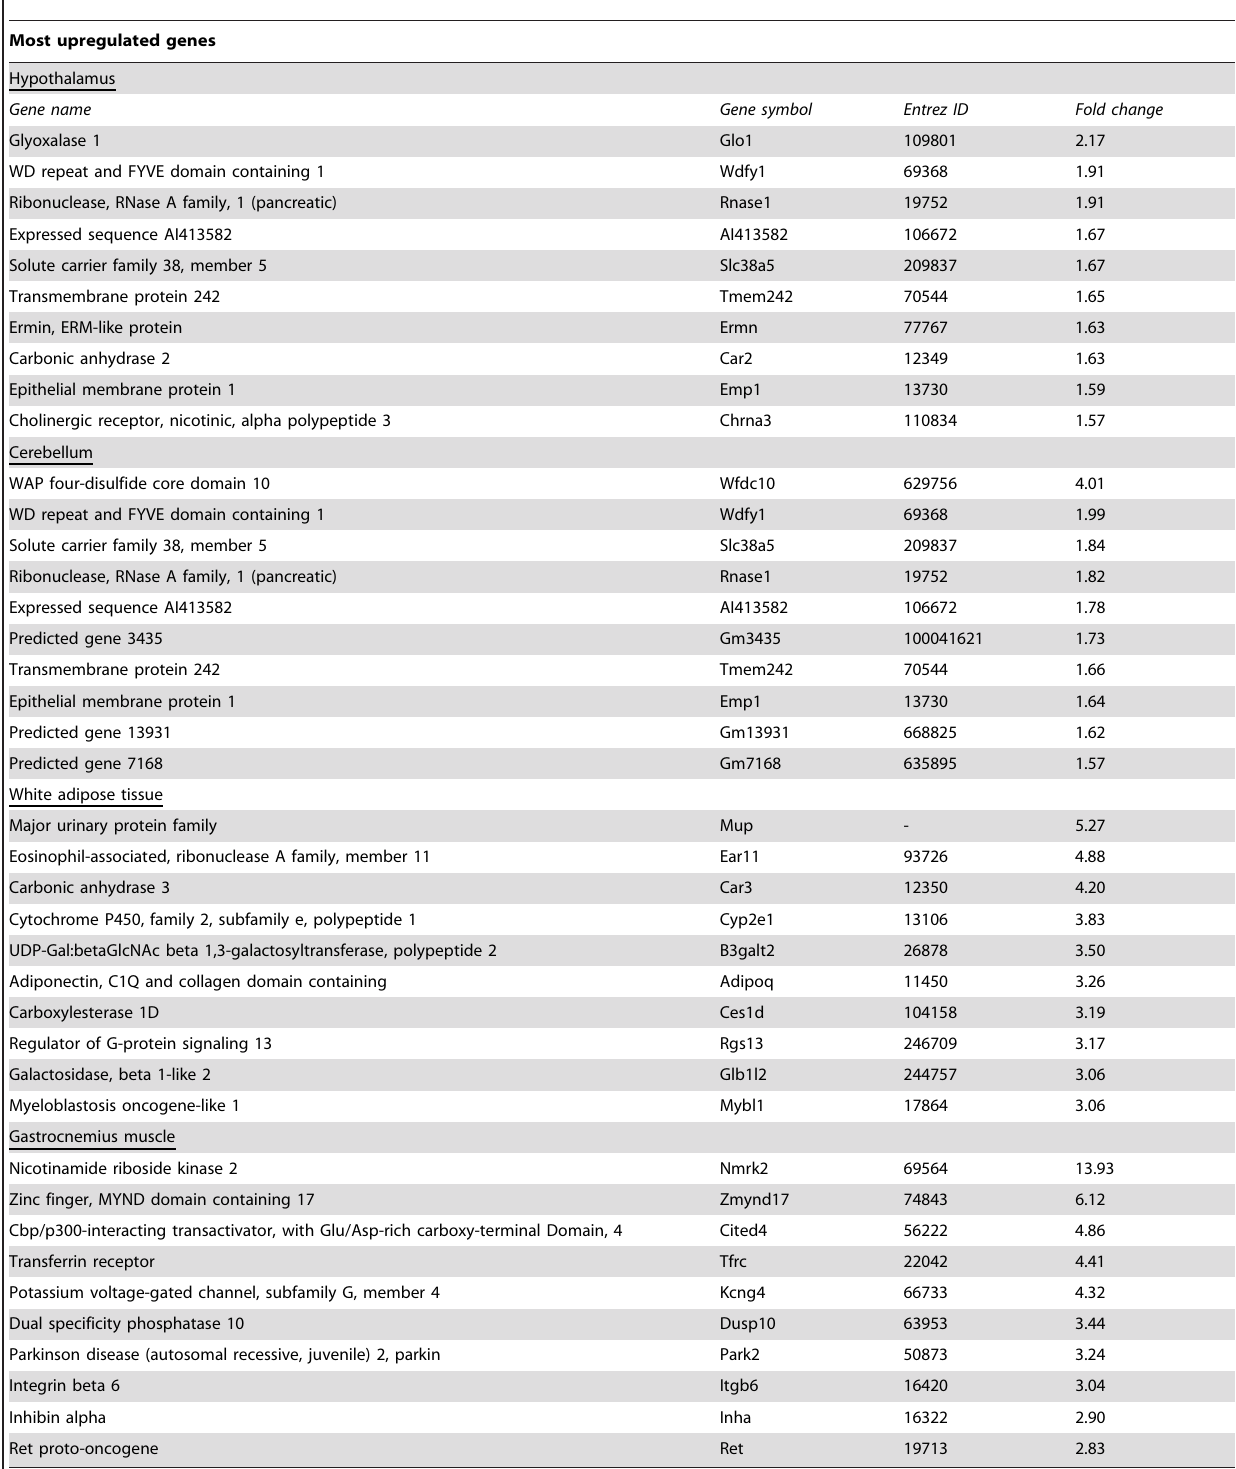
Table 1. Top 10 genes that showed the highest amount of overexpression in FTO-4 mice per tissue.